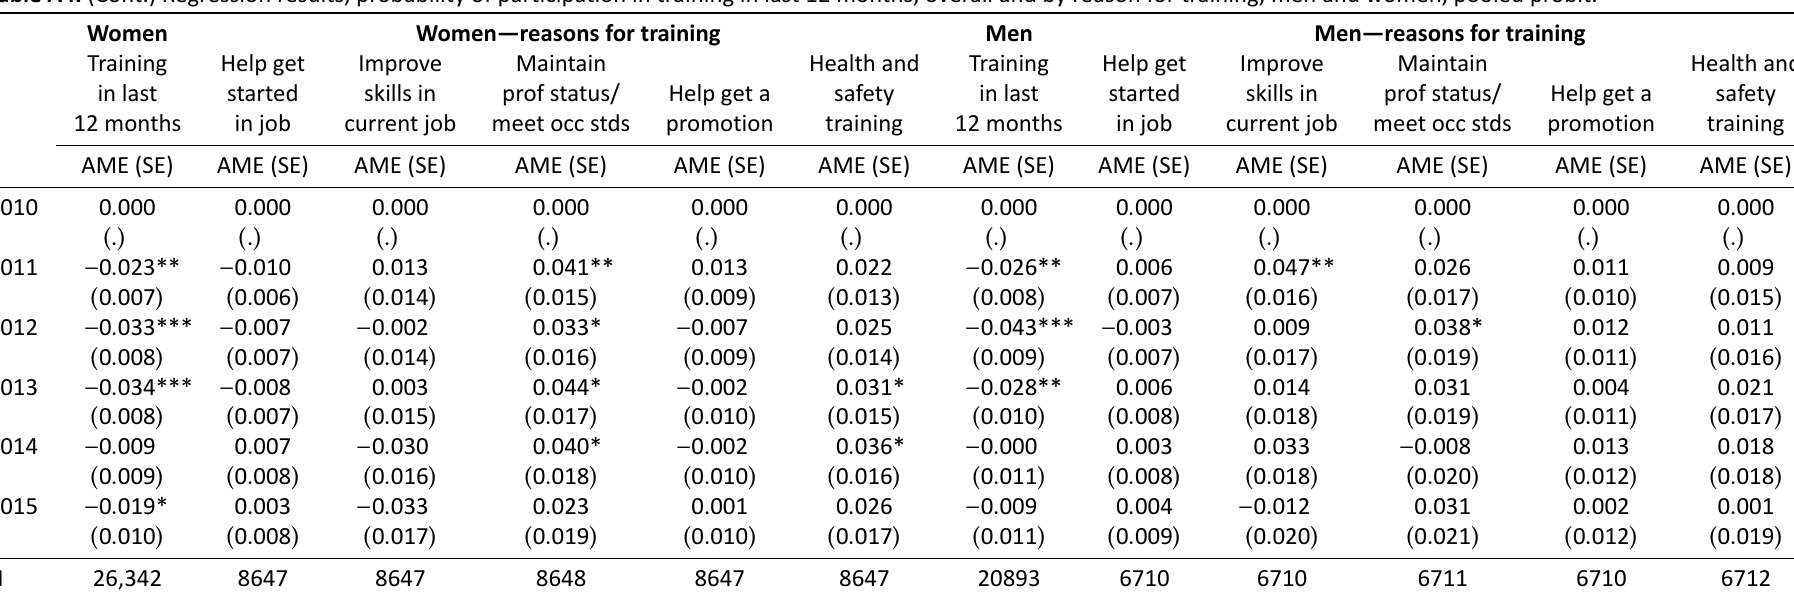
Table A4. (Cont.) Regression results, probability of participation in training in last 12 months, overall and by reason for training, men and women, pooled probit. Women Women—reasons for